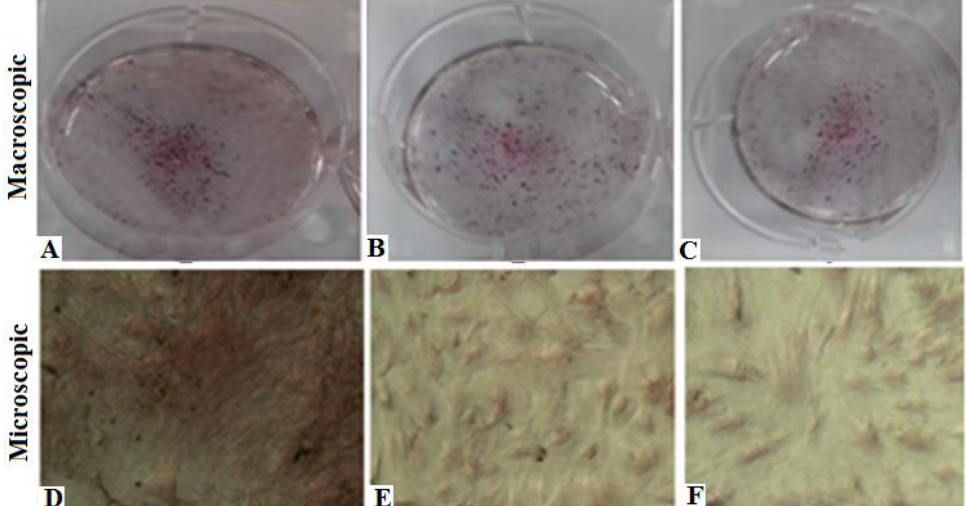
Fig. 3. Osteogenic confirmation of macroscopic and microscopic images: A and D) control group; B and E) cells treated with 1mM of DEA; C and F) cells treated with 4 mM of DEA. Table 4. Effect of DEA on sodium and potassium levels of the differentiated cell after 21 days of treatment.